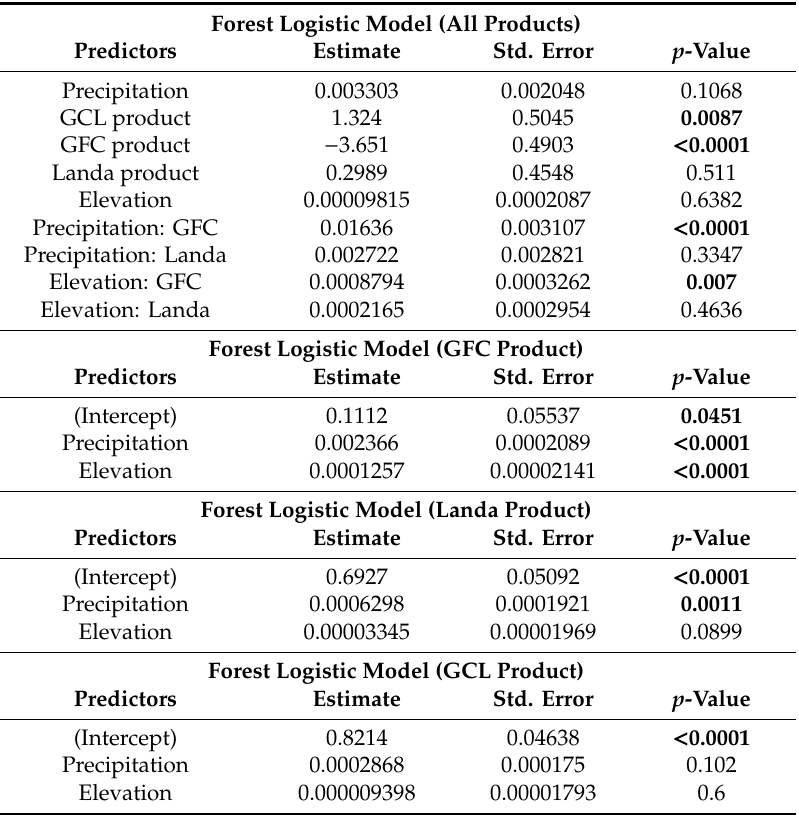
Table A4. Detailed model fits for the forest multiple logistic regressions of the probability of predicted forest cover (0 or 1) against precipitation, elevation, and product type. The data used for this analysis were forest reference data where tree cover was greater or equal to 89%. The full model fit is shown first, followed by individual model fits for each of the three tree cover products (GFC, Landa, and GCL). Forest Logistic Model (All